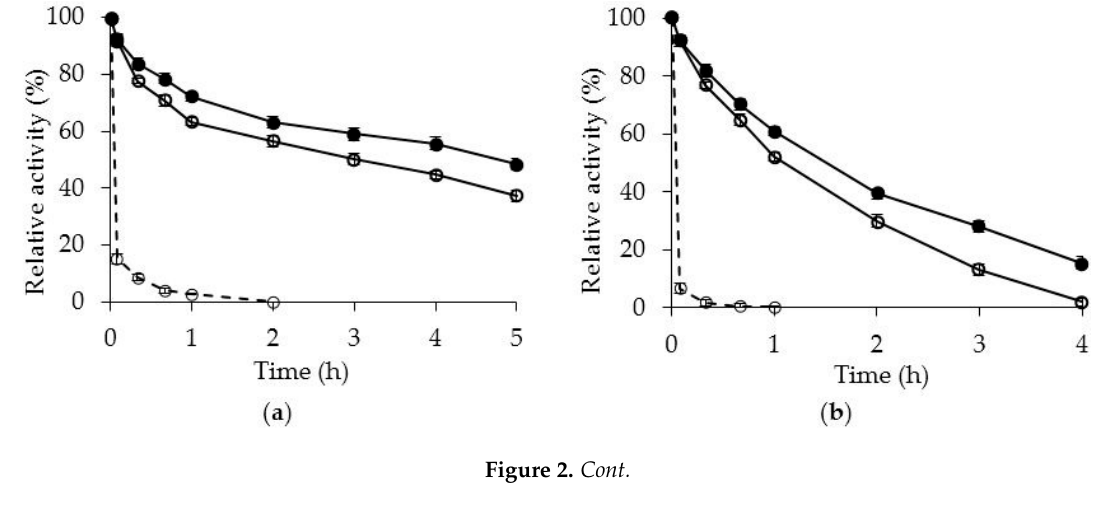
Figure 2. Cont . Figure 2.